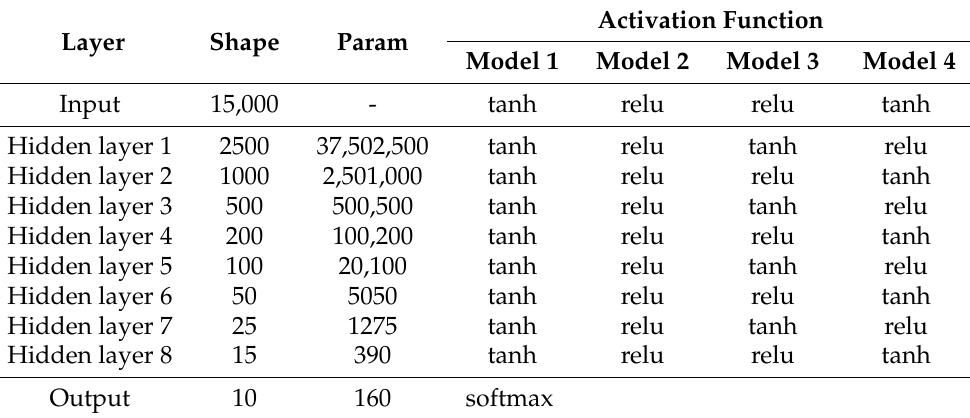
Table 3. Updated deep learning models for Case Study II. The ReLu activation function is described by Equation (4), tanh—Equation (2), softmax—Equation